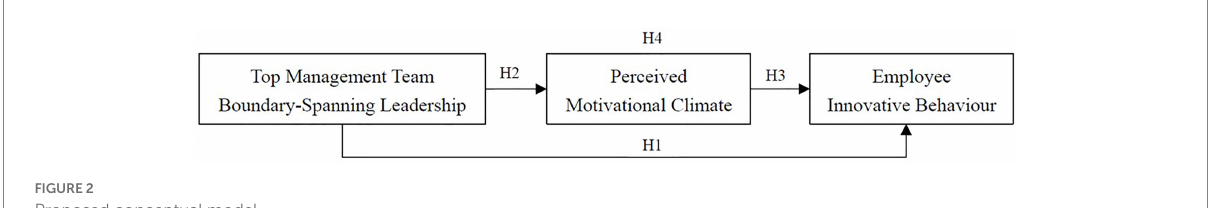
FIGURE 2 Proposed conceptual